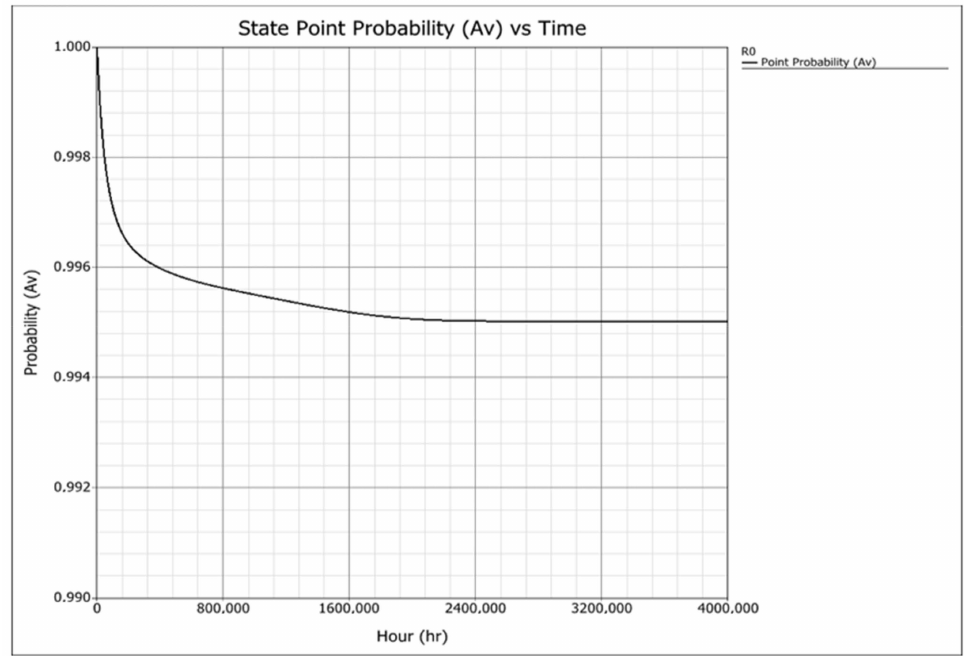
Figure 16. Probability for a focused FAS to stay in the state R 0 (t) with B-type open lines, without notifying the P SP , as a function of time (study based on computational data from the BlockSim software).